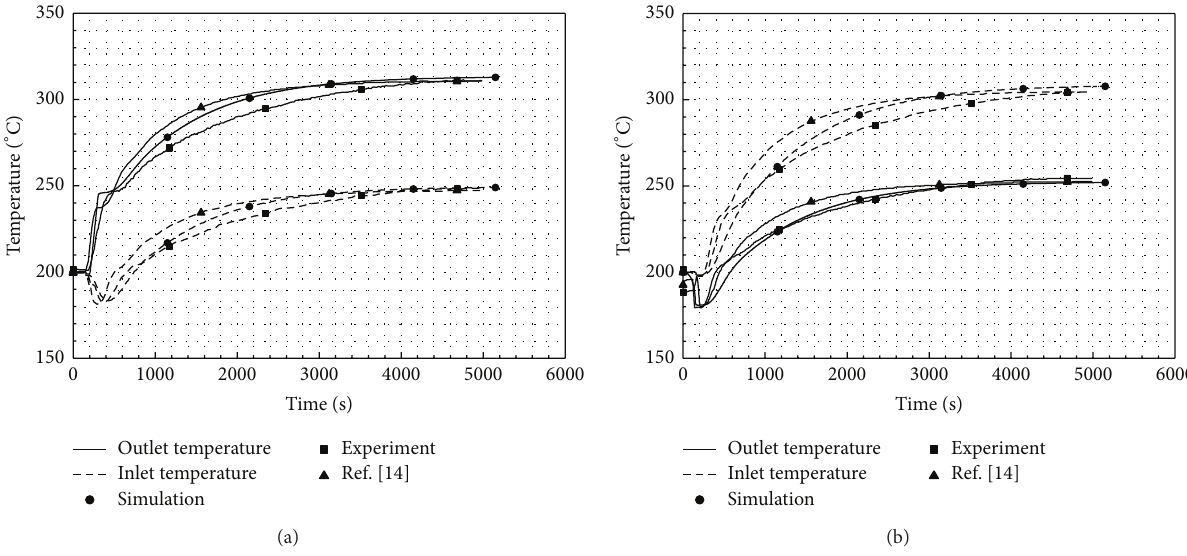
Figure 6: Inlet and outlet temperature variation of (a) core tank and (b)